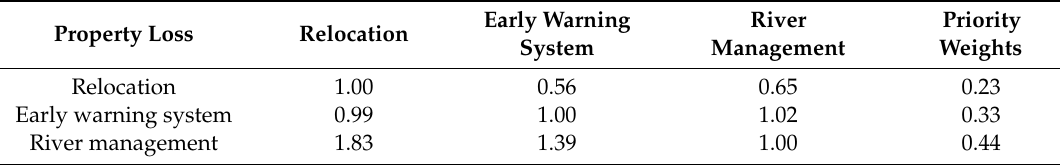
Table A2. Judgment matrix with respect to property loss